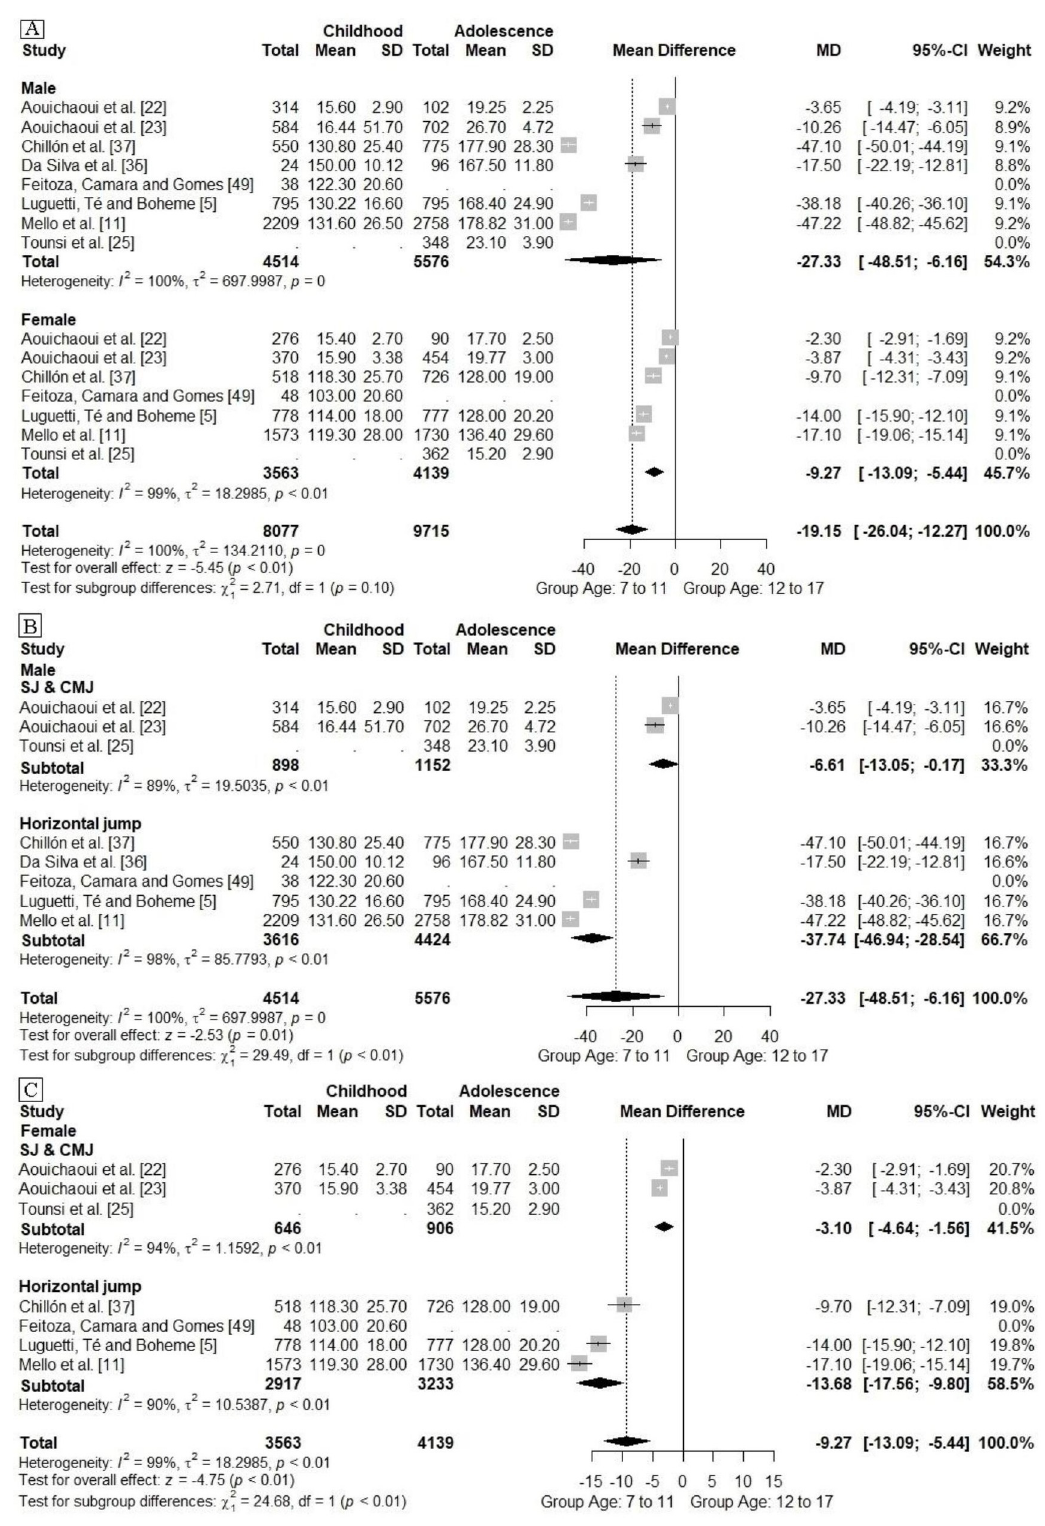
Fig 3. Meta-analysis grouping the studies by age group, sex, and by lower limbs performance analysis protocol. SJ:Squat jump. CMJ: Countermovement jump. SD: Standard deviation. MD: Mean Difference.